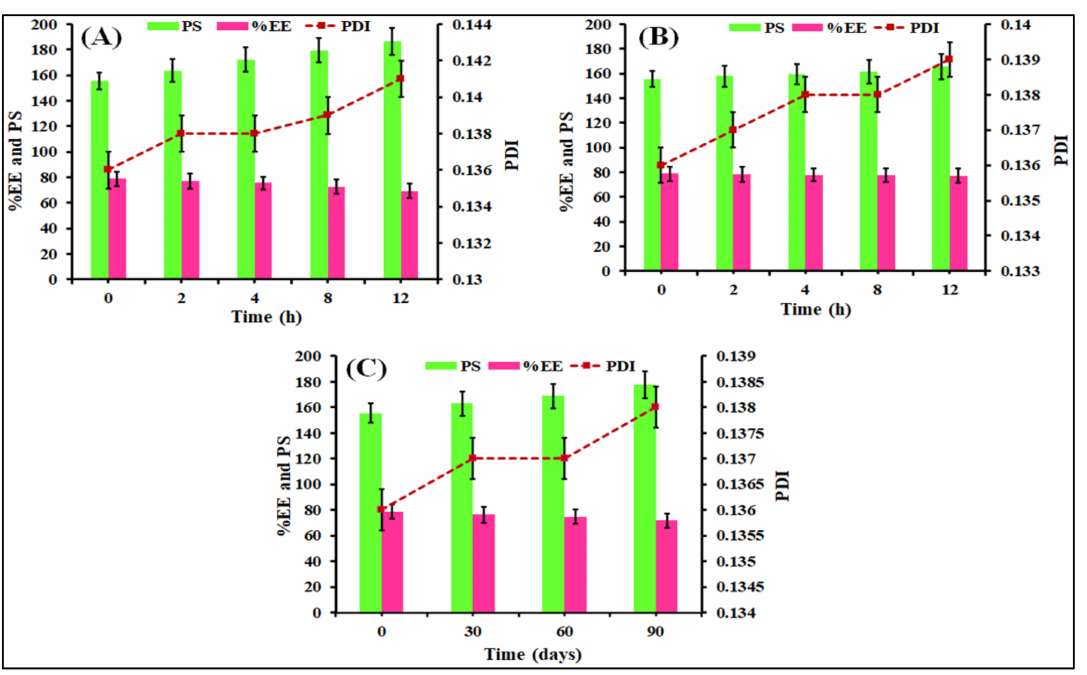
Figure 5. ( A – C ). Bar graphs showing ( A ) in vitro gastrointestinal stability study of TQ-CS-PLGA-NPs in SGF, ( B ) SIF, ( C ) colloidal stability of TQ-CS-PLGA-NPs. Results are expressed as percentage mean ± SD ( n =